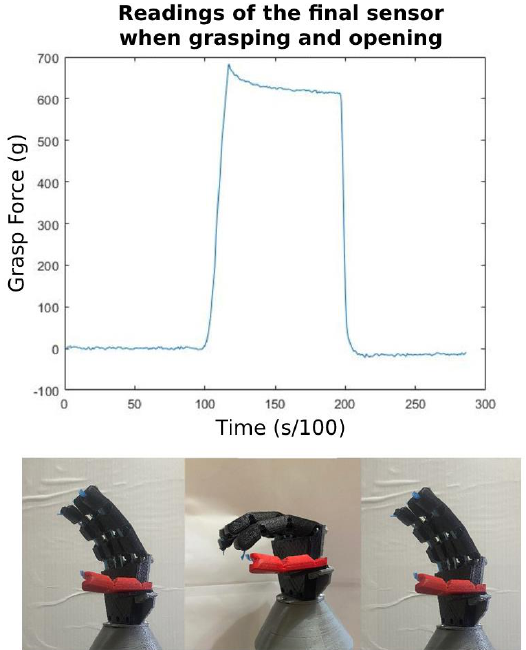
Figure 9. Readings from the final sensor as the hand opens and closes.